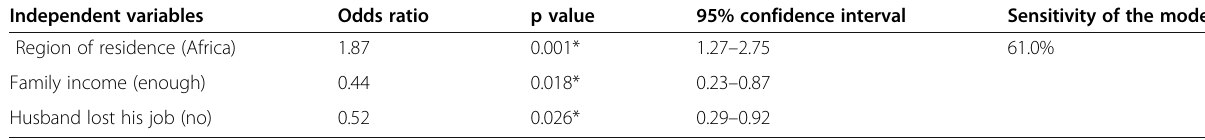
Table 4 Logistic regression analysis for the predictors of IPV among adult Arab women during COVID-19 lockdown Independent